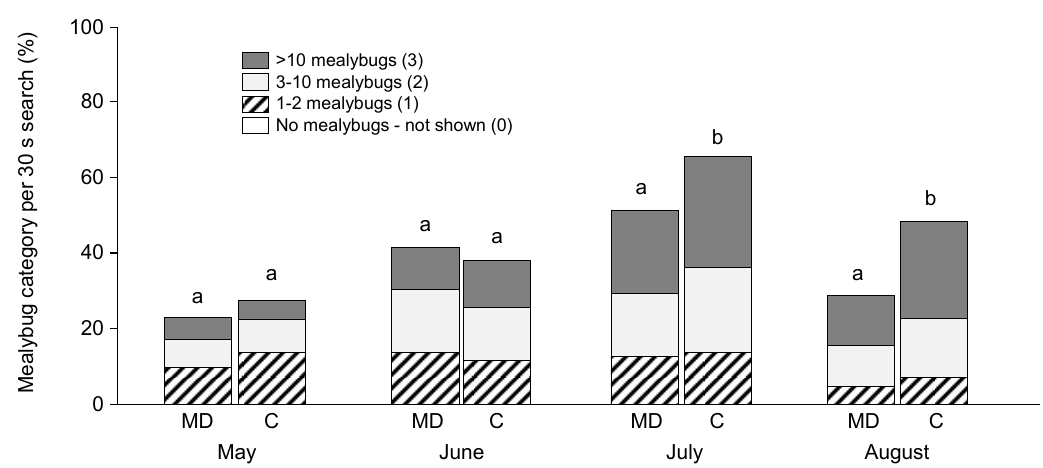
Figure 10. The categorical ranking of mealybug density showed no treatment difference in 2007 in May ( χ 2 = 4.639, df = 3, p = 0.200) or June ( χ 2 = 2.854, df = 3, p = 0.415) and significantly less damage on vines in the mating disruption (MD) than the control (C) in July ( χ 2 = 20.65, df = 3, p < 0.001) and August ( χ 2 = 41.05, df = 3, p < 0.001). For each month, different letters above each bar represent significant differences.